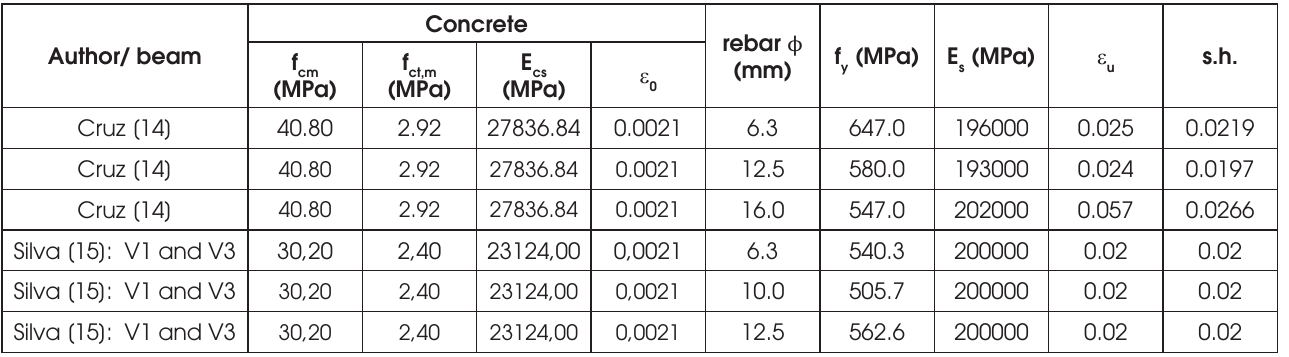
Material properties for beams tested by Cruz [14] and Silva [15] Author/ beam